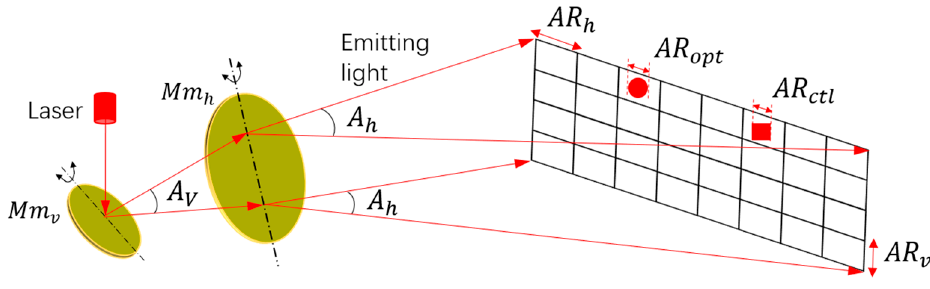
Figure 1. Angular resolution in a separate-axis Lissajous scanning MEMS LiDAR system.